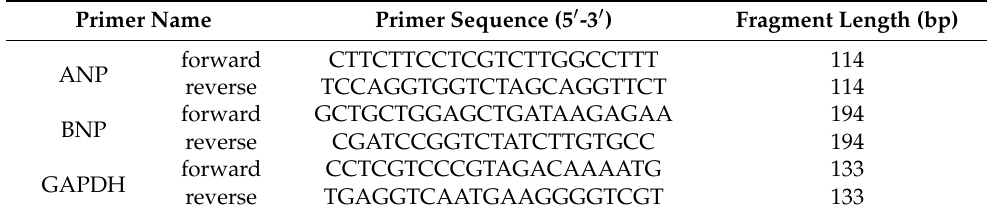
Table 1. Primer sequences for hypertrophy genes.